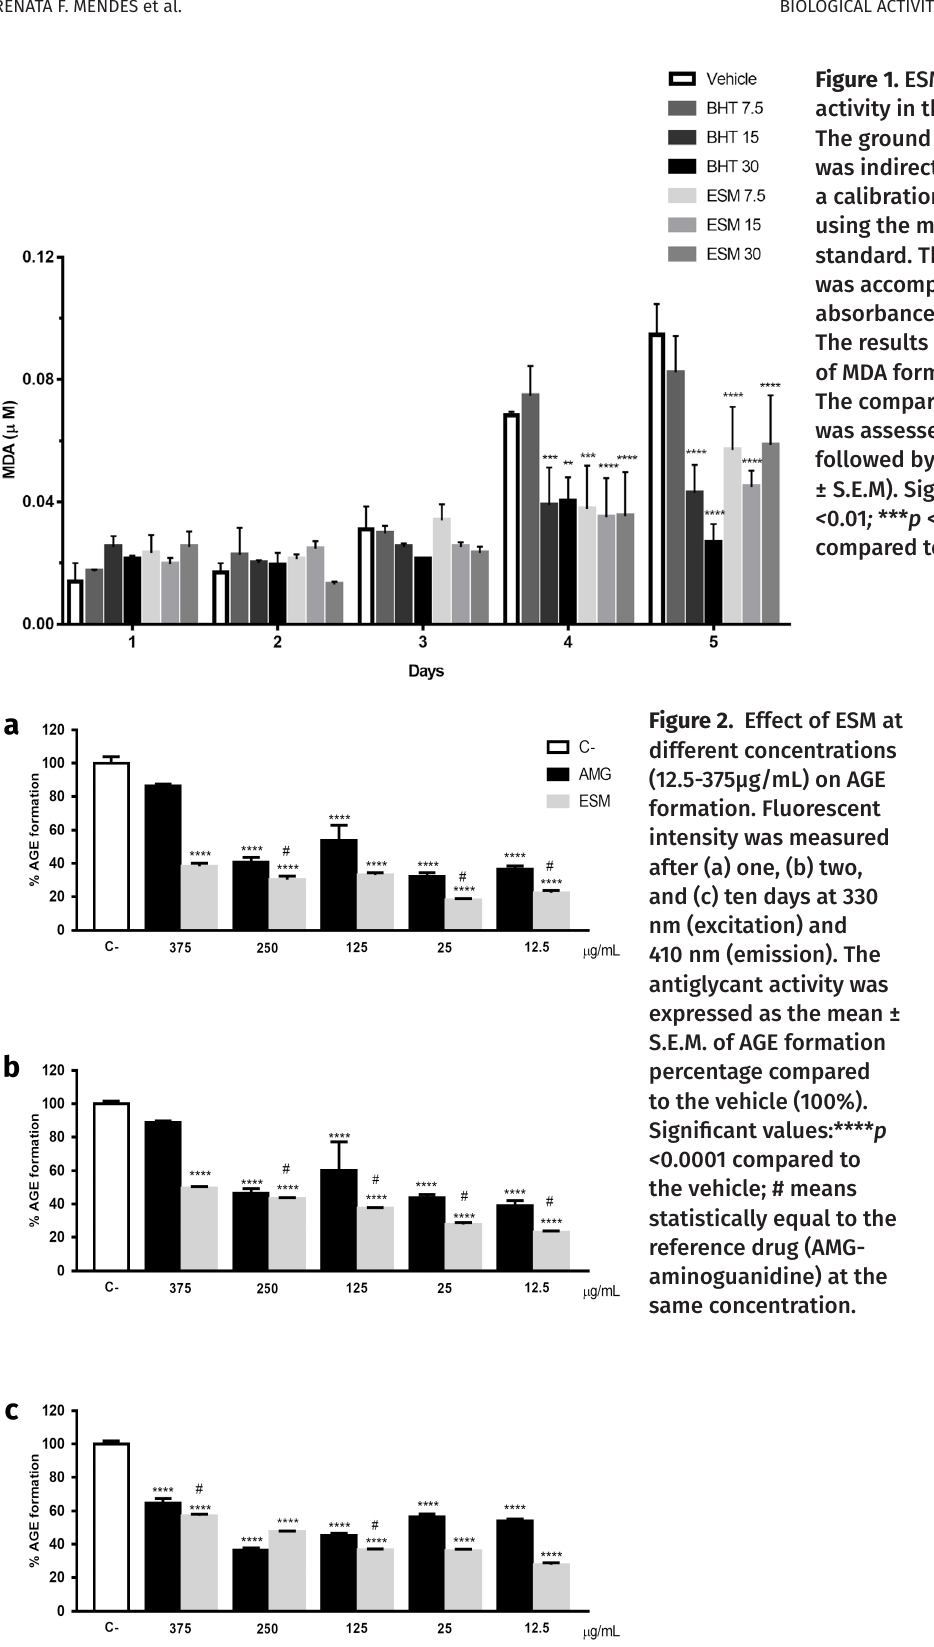
standard. The measurement